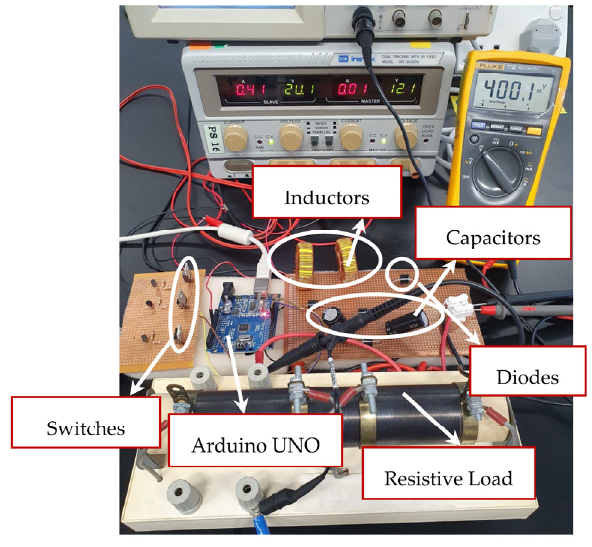
Figure 8. Proposed converter’s hardware prototype setup. Table 2. Proposed converter’s design parameter.